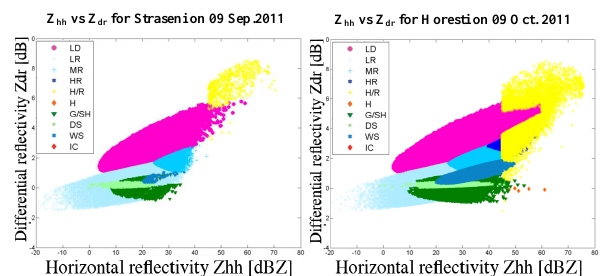
2 Figure 7. As in figure 6, but using the HydroAlg classification technique applied to mini-radar Fig. 7. As in Fig. 6, but using the HydroAlg classification technique volume acquisitions during MOF rain events on Sep. 9 and Oct. 9, 2011 for Straseni and applied to mini-radar volume acquisitions during MOF rain events Horesti sites. on 9 September and 9 October 2011 for Straseni and Horesti sites. 3 3 Figure 9. Statistical difference between R3 mini-radar and XPol measurements versus range Fig. 9. Statistical difference between R3 mini-radar and XPol mea- surements versus range during the 8–9 October 2011 rain event for during the 8-9/10/2011 rain event for two different antenna elevation angles. two different antenna elevation 4